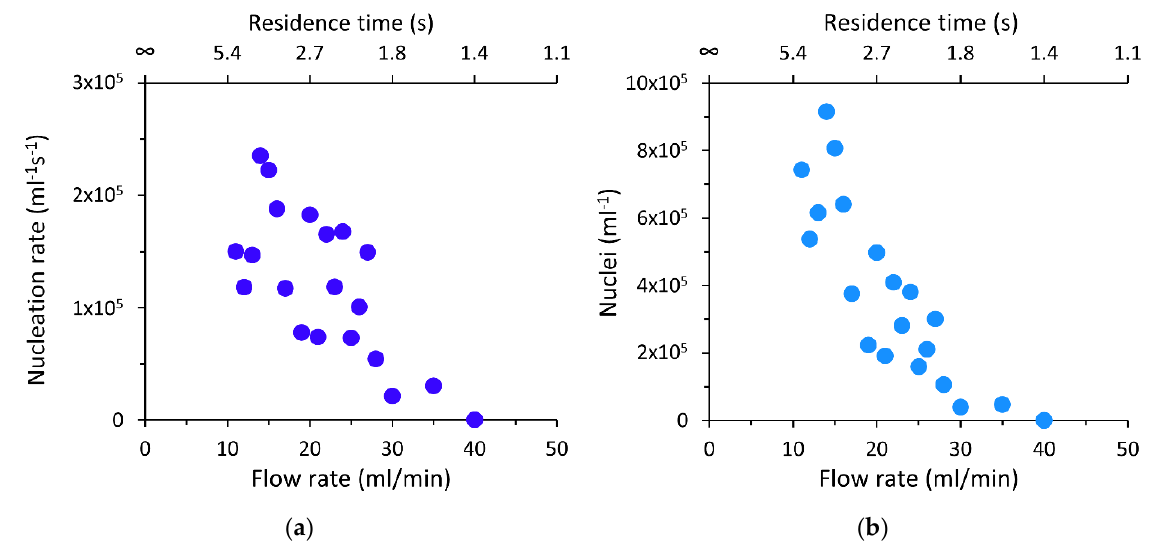
Figure 6. Influence of the flow rate and the residence time on the nucleation rate ( a ), and the total number of formed nuclei in the ultrasound-irradiated zone ( b ).